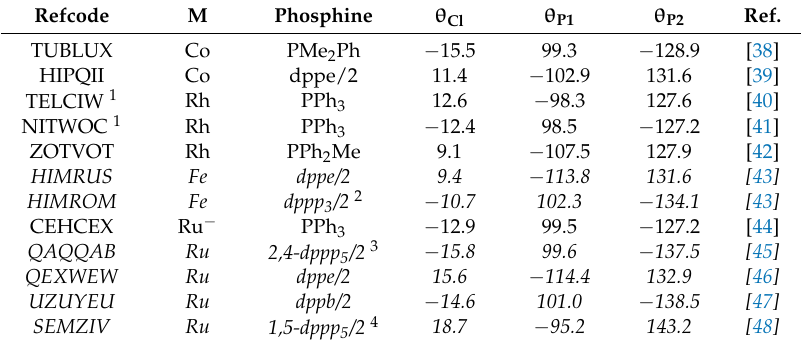
Table 5. ELO data ( θ , / ◦ ) in [3,3-P 2 -3-Cl- closo -3,1,2-MC 2 B 9 H 11 ] species (P = phosphine or P 2 = diphosphine).